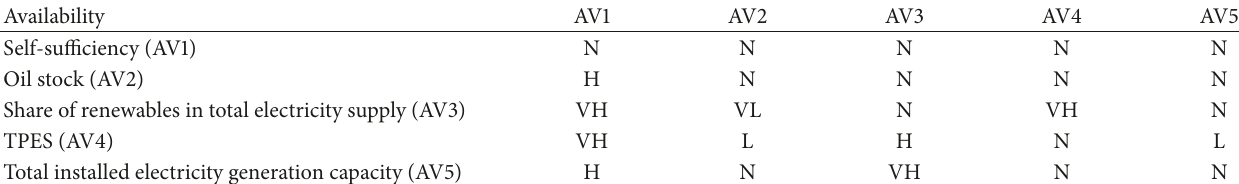
Table 6: Direct-influenced relation matrix using linguistic values for Availability (Case 2 ).